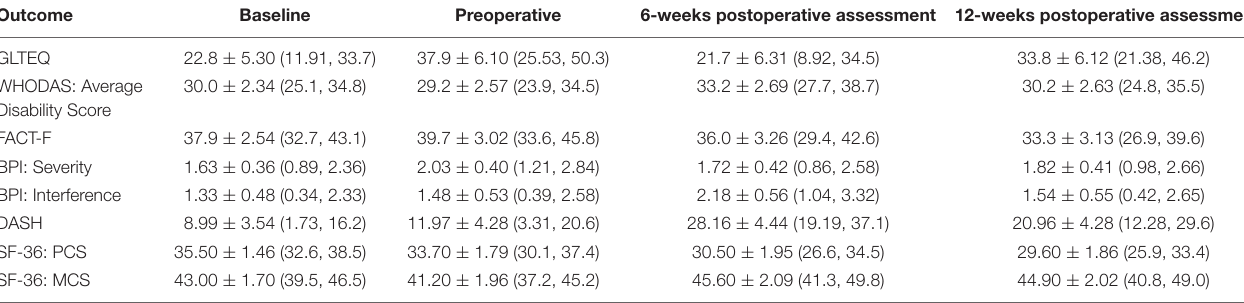
TABLE 3 | Mean estimates ± SE (95% CI) for participant-reported outcomes ( n = 22). Outcome Baseline Preoperative 6-weeks postoperative assessment 12-weeks postoperative